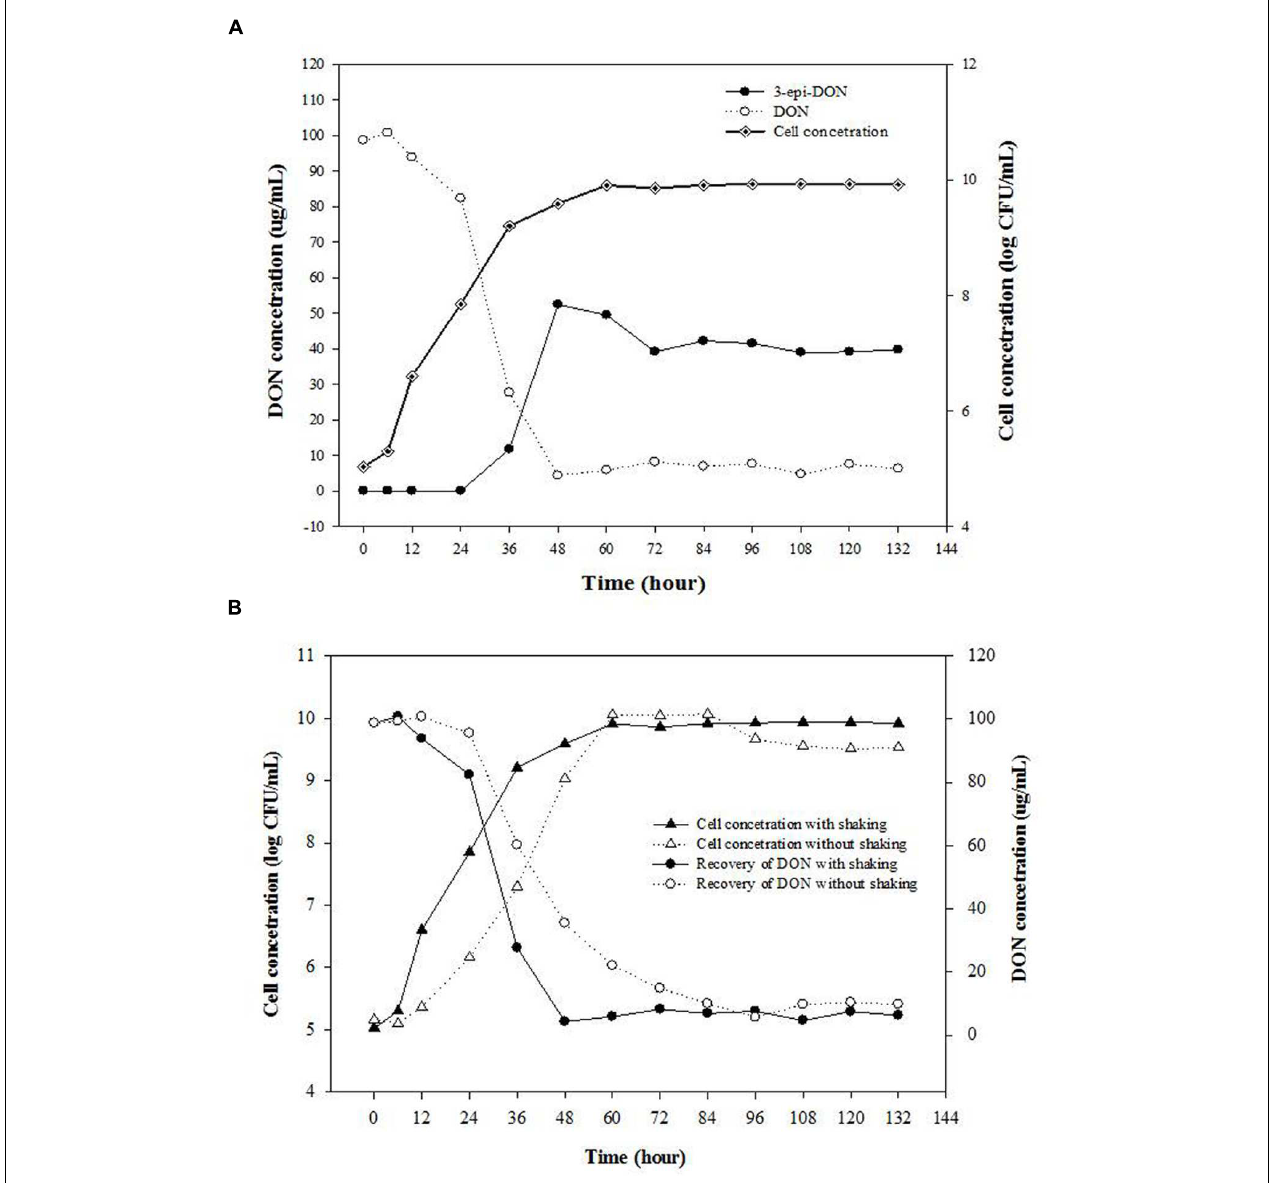
FIGURE 1 | Isolate 17-2-E-8 is capable of transforming DON into 3 -epi- DON as a major product under aerobic conditions. (A) The effect of incubation times on the bacterial growth and DON concentrations in corn meal broth (CMB) cultures containing 100 µ g/mL DON and inoculated with bacterium 17-2-E-8. The cultures were kept shaking (200 rpm) at 28 ◦ C. The PLSD ( 0 . 05 ) of the tests for concentration of DON and 3 -epi -DON, and cell concentration were 7.6 and 0.38, respectively. (B) The effects of shaking on bacterial cell numbers of isolate 17-2-E-8 and reduction of DON levels in CMB cultures containing 100 µ g/mL DON. The PLSD ( 0 . 05 ) of the tests for DON concentration and viable cell numbers were 8.1 and 0.38, respectively.